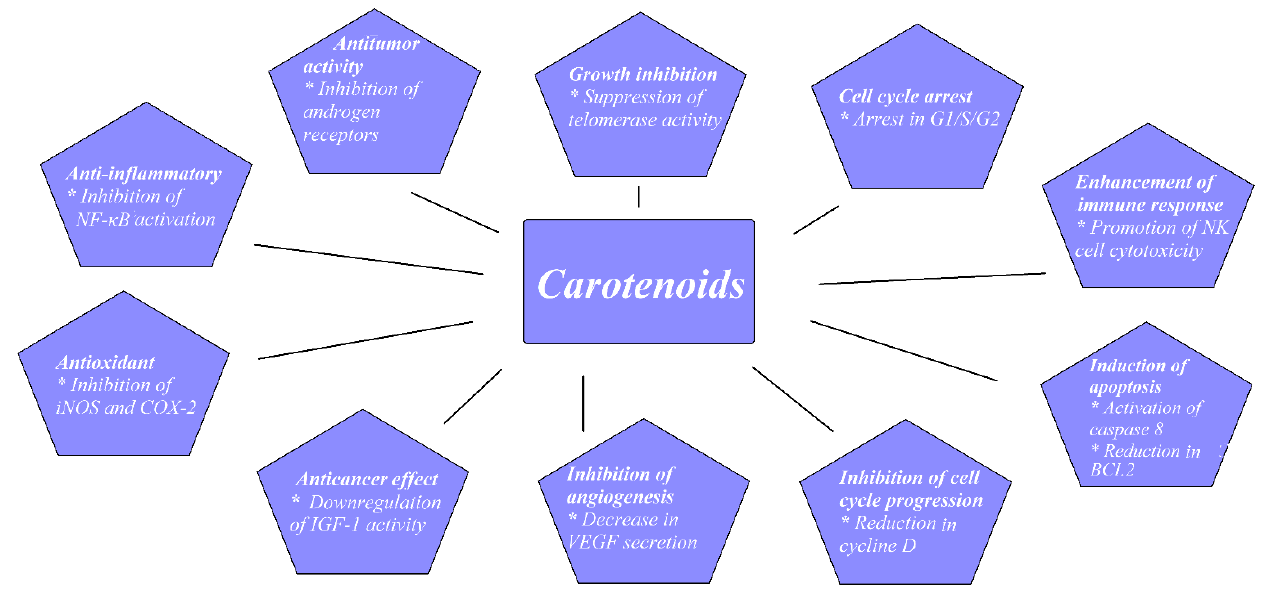
Figure 1. Proposed mechanisms for carotenoids preventing cancer development. Based on figures from Milani et al. [14].